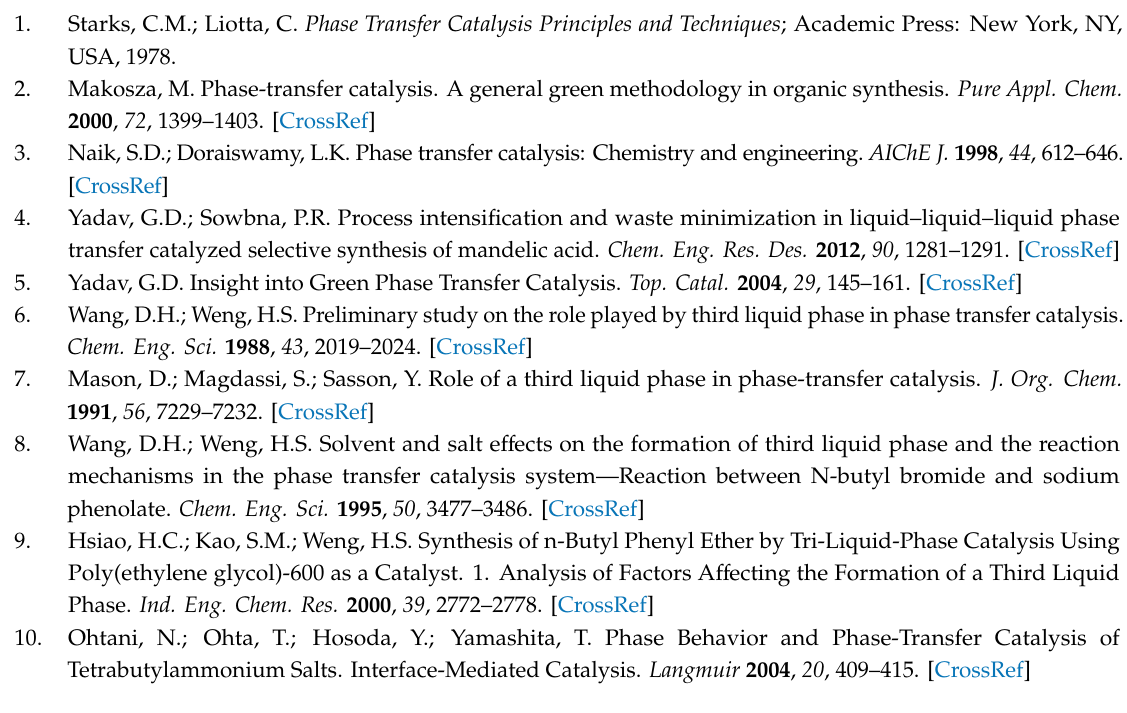
Figure S1: Schematic diagram of the front section the reactor vessel, Figure S2: Front view of the actual reactor vessel, Figure S3: Schematic diagram of a top view of the reactor vessel, Figure S4: GCMS spectra of (A) epichlorohydrin, (B) guaiacol glycidyl ether, (C) reaction by-product, and (D) n-decane, Figure S5: Typical GC chromatogram of reaction